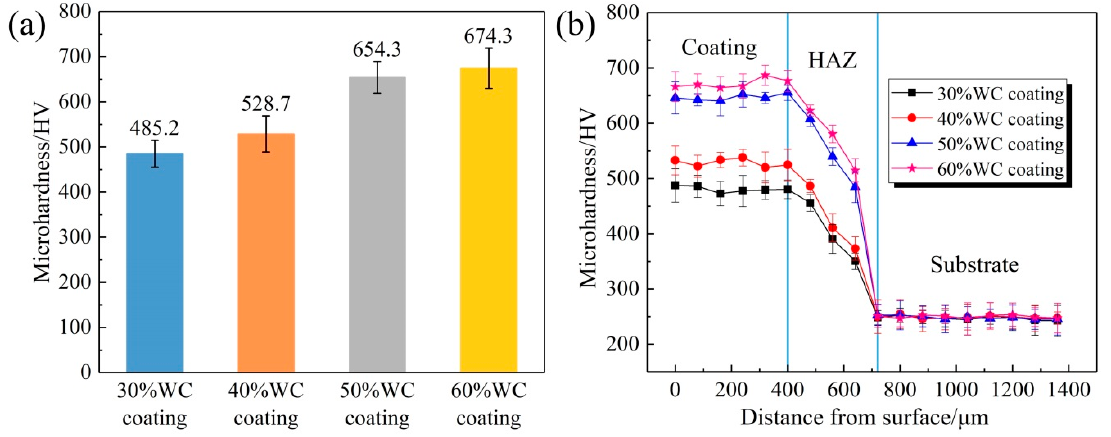
Figure 5. ( a ) The surface hardness of the samples and ( b ) the cross-sectional hardness of the sam-